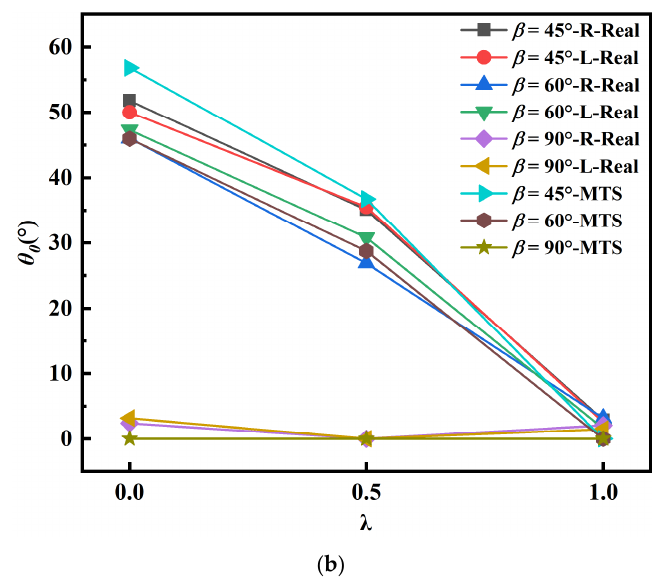
Figure 7. Crack initiation angle and real crack path under different biaxial load ratios. ( a ) Real crack paths from test specimens (λ = 0.5) and ( b ) real crack propagation angle and predicted crack propagation angle by MTS criterion.